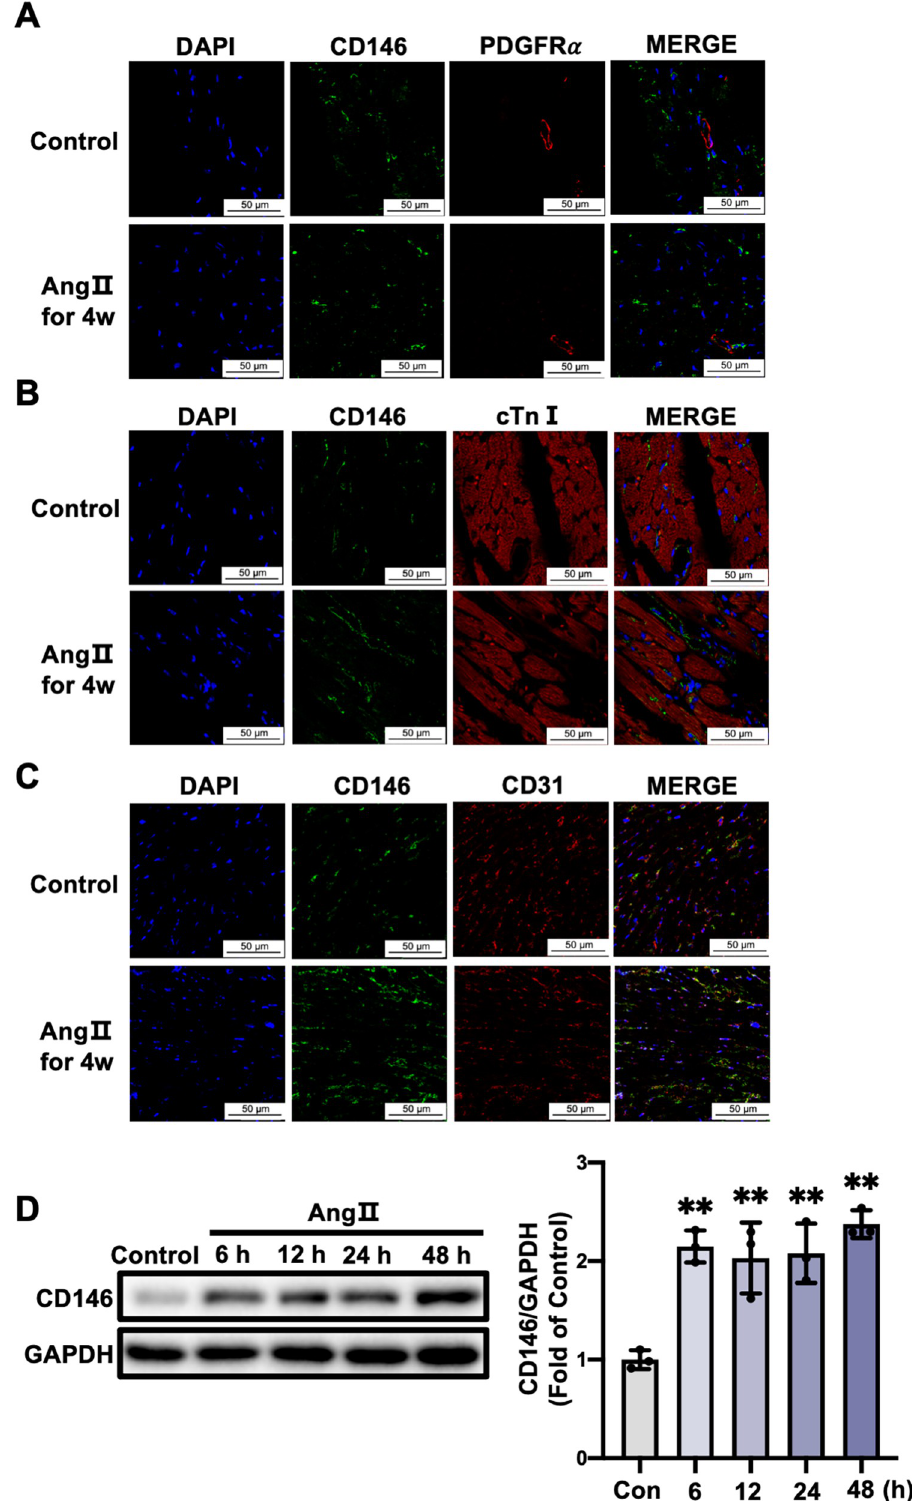
Fig 3. CD146 upregulation by Ang II is mainly restricted to cardiac ECs. Representative double– immunofluorescence images of CD146 with PDGFR α ( A ), cTnI ( B ) and CD31 ( C ) in left ventricles from control and 4–week Ang II–infused mice (scale bars indicate 50 μ m). Green represents CD146; red represents PDGFR α , cTnI and